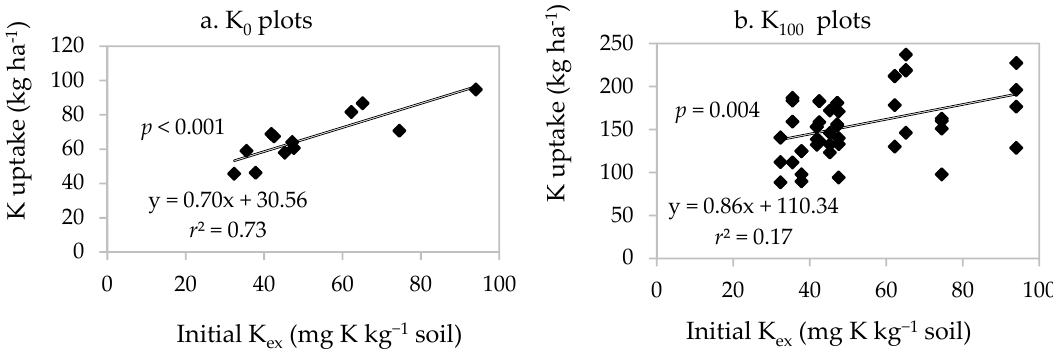
Figure 8. The relationship between initial soil K ex and K uptake in ( a ) control plots, K 0 (n = 12) and ( b ) K-fertilizer applied plots, K 100 (n = 48) in three field experimental sites in Bangladesh. ‘n’ indicates number. Table 6. Effect of K fertilization on K concentration and K uptake, and agronomic and recovery efficiency of K by rabi maize in three field experimental sites in Bangladesh, 2012–2013.